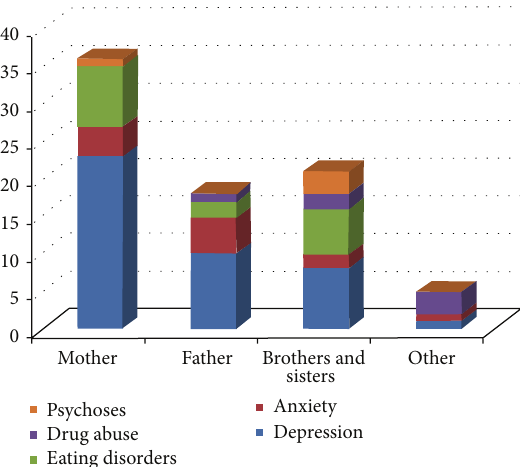
Figure 1: Family history of psychiatric